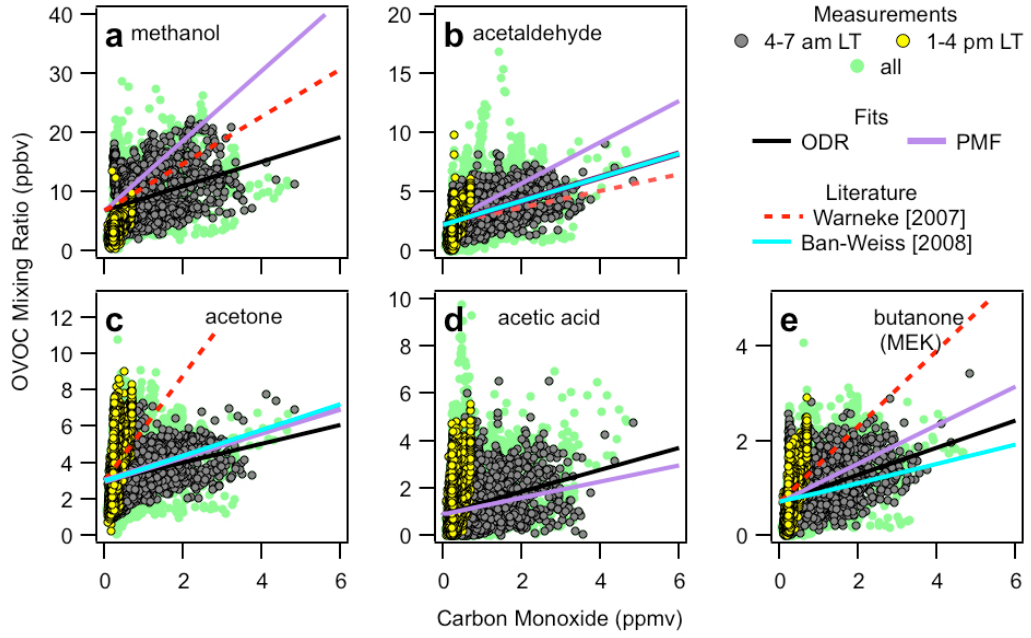
Figure 8. Plots used to calculate emission ratios with respect to carbon monoxide (CO) for 5 OVOCs quantified by PIT-MS. Emission ratios calculated from measurements using 2-sided regression fits (black) and Positive Matrix Factorization results (purple) during MILAGRO are compared to literature values obtained during field studies in New England (red) and to a California tunnel study (blue). 1-Minute PIT-MS data show afternoon enhancements in OVOCs typically observed during the campaign. For comparison purposes, lines showing PMF and literature ERs are shown with intercepts obtained from ODR fits of MILAGRO measurements. PMF lines represent ERs obtained by summing the traffic and LPG factors.